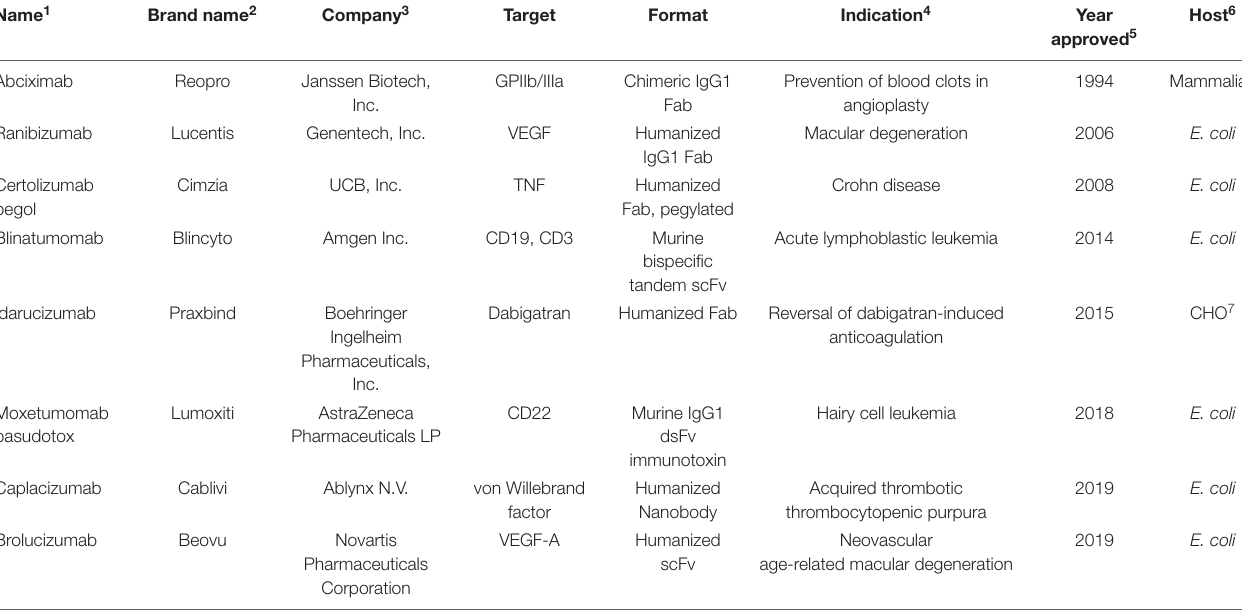
TABLE 1 | FDA approved therapeutic antibody